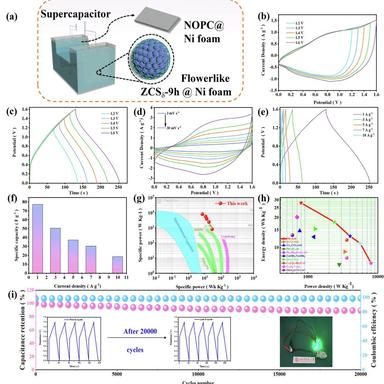
(a) Schematic illustration of fabrication of ZCSd-9h//NOPC HSC; (b) CV and (c) GCD curves of HSC; (d) CV and (e) GCD curves of HSC; (f) Histogram illustrating the specific capacity of HSC; (g) Ragone plot of HSC (the values of other energy-stored devices are also added to the graph for the purpose of comparion); (h) Ragone plot of HSC (specified values of the devices please see to tabel 1); (i) The cycling performance of HSC at 2 A g1 (the illustration presents the pre and post 5 cycles of the GCD curves fo